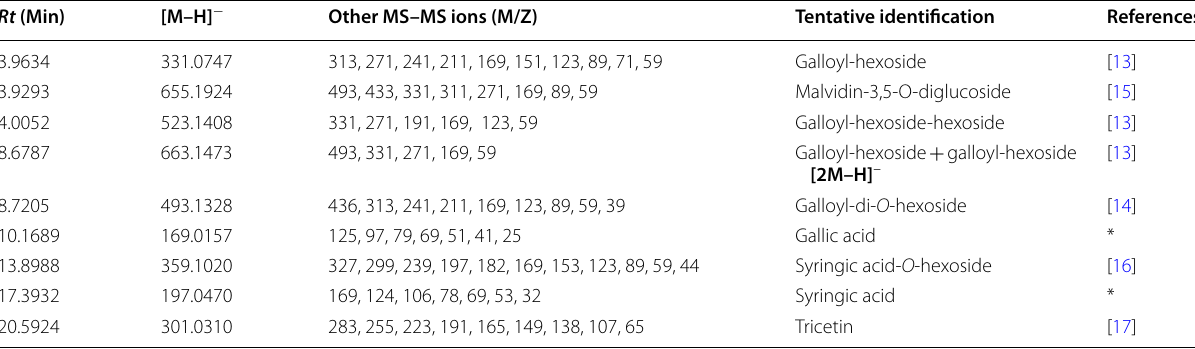
* Compounds identified by comparing retention times and MS data with those of reference compounds